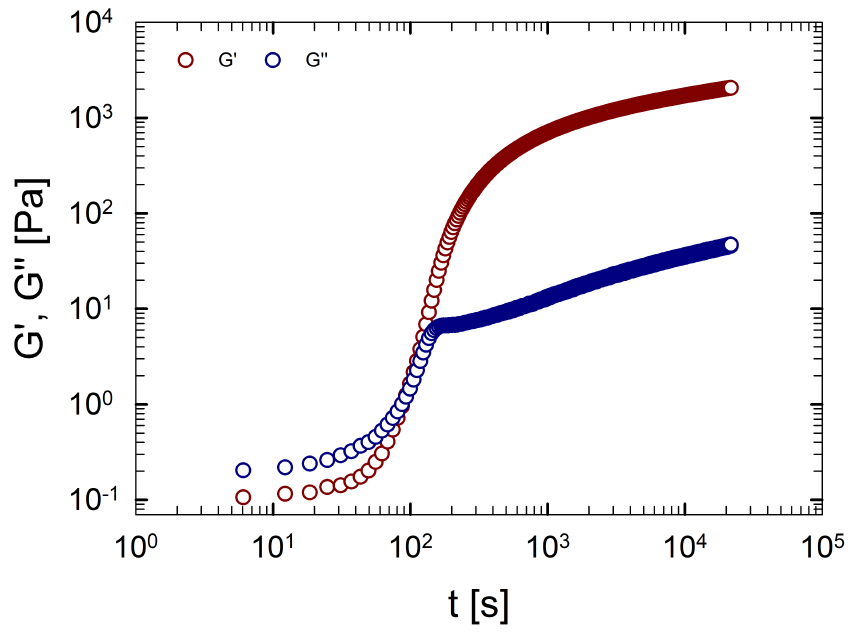
Figure 6. Storage modulus G 0 (red circles) and loss modulus G 00 (blue circles) as a function of the time for an aqueous gelatin solution (Sol. 2) at 22°C.